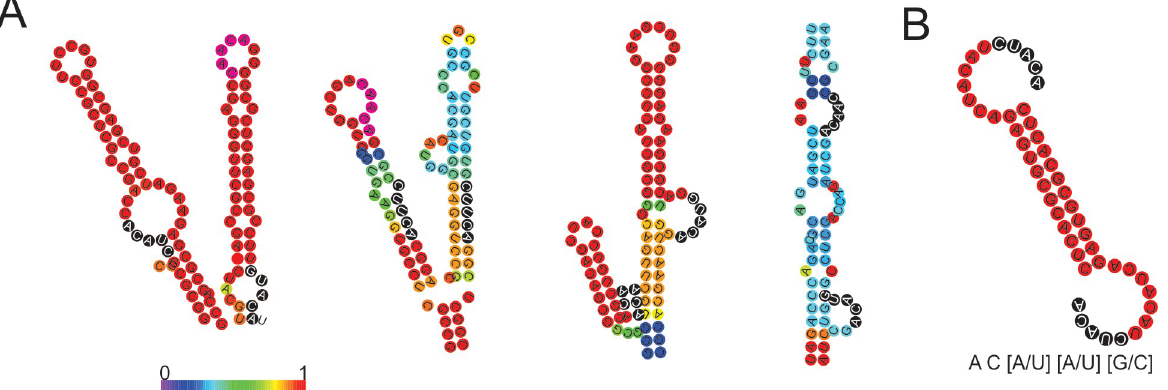
Fig 5. Preferred target sites identified in sigF are positioned within stems and loops. (A) Four major stem-loop secondary structures taken from the predicted secondary structure of sigF RNA and (B) predicted secondary structure of 5’5 RNA and the preferred target sequence [11]. The stem loops are coloured by base pair probability and the preferred target sequences are highlighted with black circles and white text. RNA secondary structure was modelled by RNAfold [21].